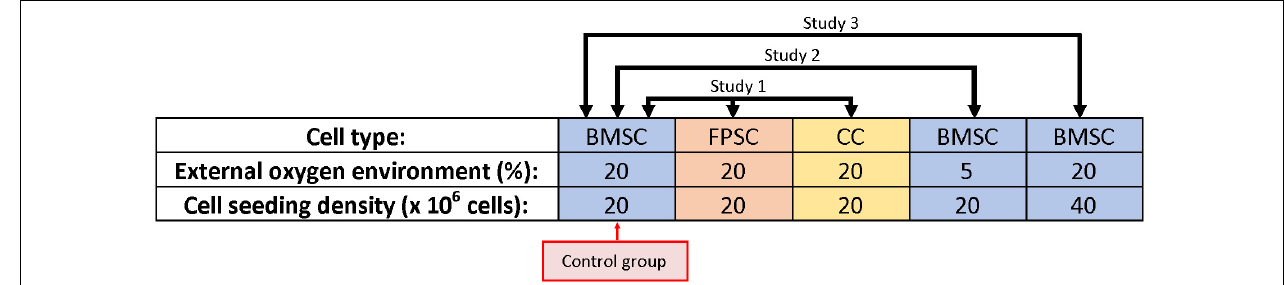
FIGURE 1 | Study schematic; three studies were performed in parallel using a shared control